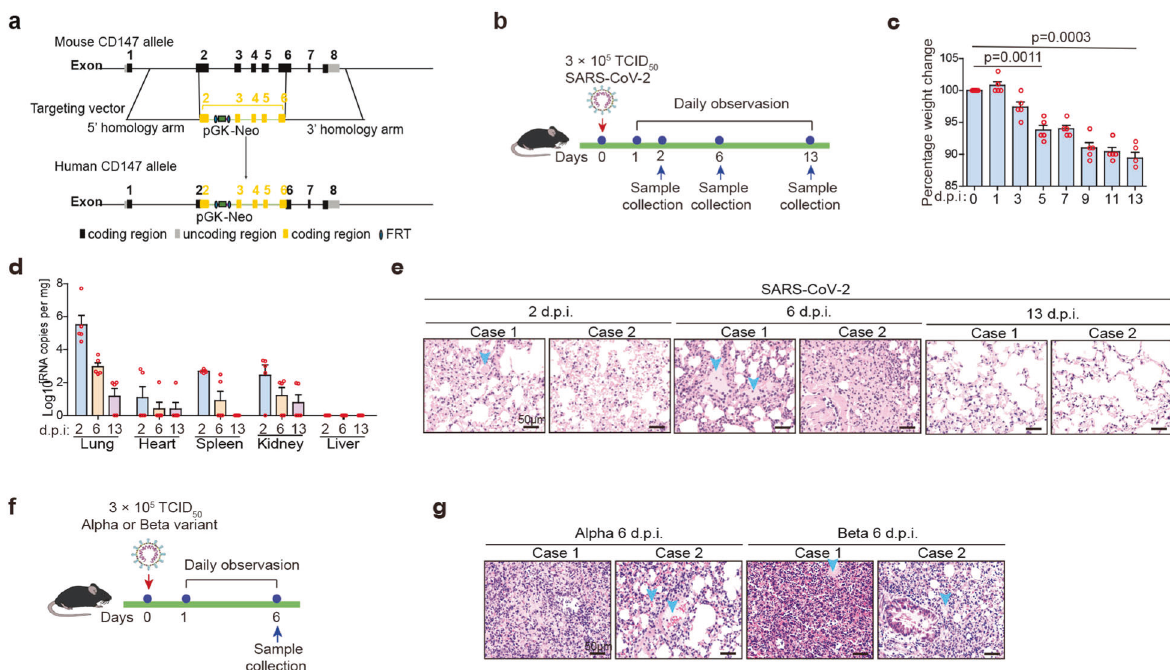
Fig. 2 Humanized CD147 transgenic mouse model with SARS-CoV-2 and variants infection mimics COVID-19 pathology. a Schematic diagram of the method to construct hCD147 mice. b Inoculation of hCD147 mice via the intranasal at 3 × 10 5 TCID 50 of SARS-CoV-2, and sample collected at 2, 6, and 13 d.p.i. c Weight changes were monitored ( n = 5). d Taqman RT-qPCR for viral RNA levels in the lung, heart, spleen, kidney, and liver ( n = 5). e H&E staining of lung tissue sections from infected hCD147 mice (scale bars, 50 μ m). f hCD147 mice were inoculated via the intranasal route with 3 × 10 5 TCID 50 of alpha or beta variant, and sample collected at 6 d.p.i. g H&E staining of lung tissue sections from infected hCD147 mice (scale bars, 50 μ